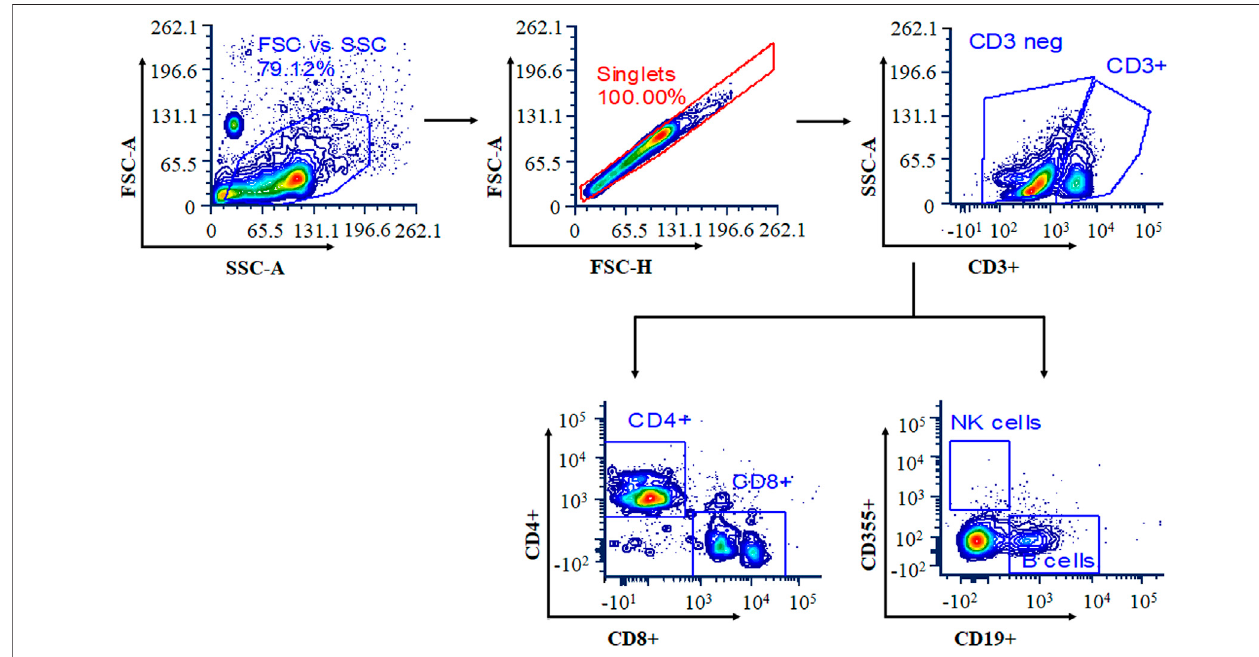
FIGURE 1 | Gating strategy for selected populations of T cells, B cells, and natural killer (NK) cells. Cells were stained with a panel of cell-speci fi c antibodies conjugated with different fl uorochromes: CD3e-FITC, CD4-PE, CD8-APC, CD19-APC, and